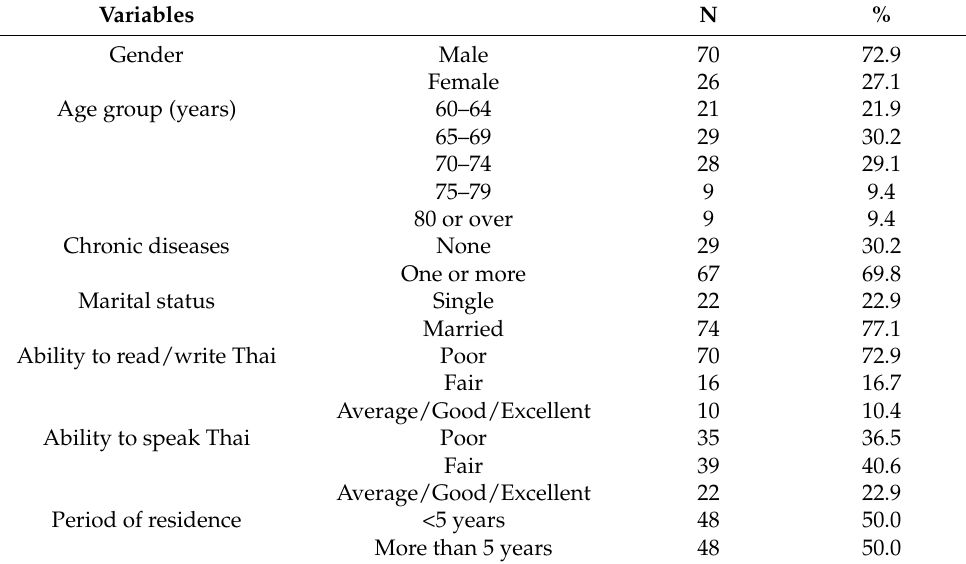
Table 1. Socio-demographic status of Japanese older people living in Chiang